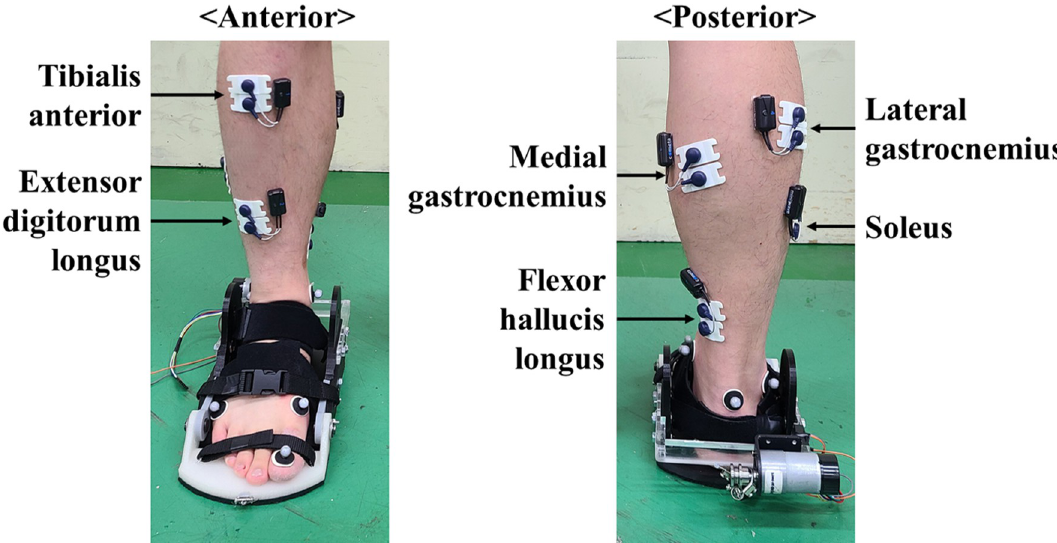
Fig 5. Placement of the electrodes on the right ankle and MTP muscles. Surface EMG signals from the flexor hallucis longus, extensor digitorum longus, tibialis anterior, gastrocnemius medialis, gastrocnemius lateralis, and soleus were collected during the